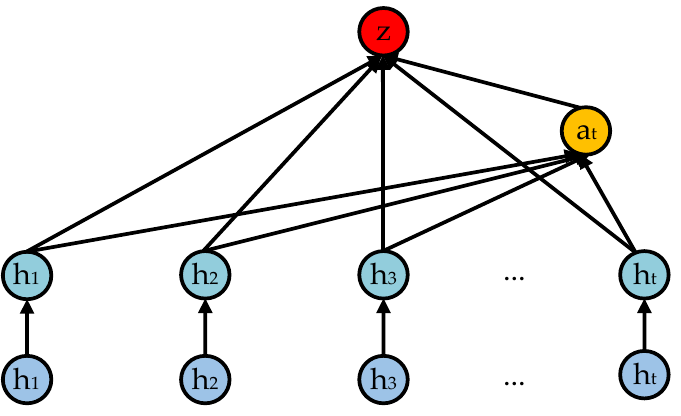
Figure 4. Structure diagram of AM.